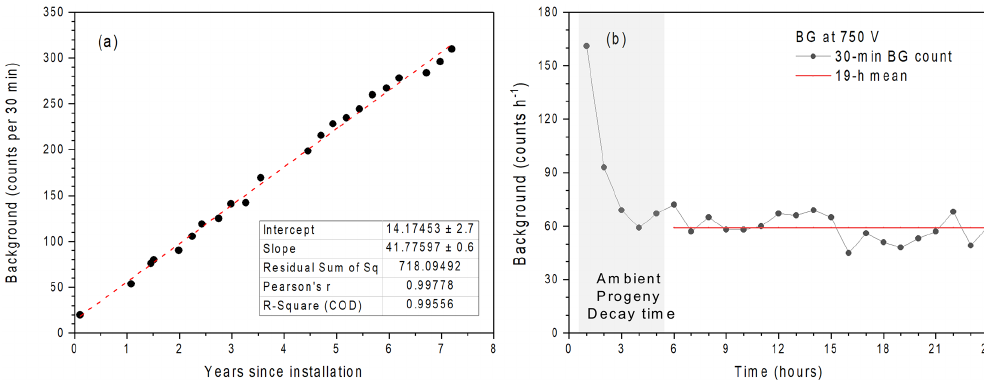
Figure 5. Example (a) 7-year background record with linear model, for a 1500L two-filter dual-flow-loop detector sampling from 2ma.g.l., ∼ 55km inland near Sydney, Australia, and (b) a single 24h instrumental background check under field conditions. Regarding (a) , the annual average radon concentration at this site was 6.8Bqm − 3 , afternoon minimums were typically between 0.8–2.2Bqm − 3 , and peak nocturnal values in late autumn were 23 ± σ 14Bqm − 3